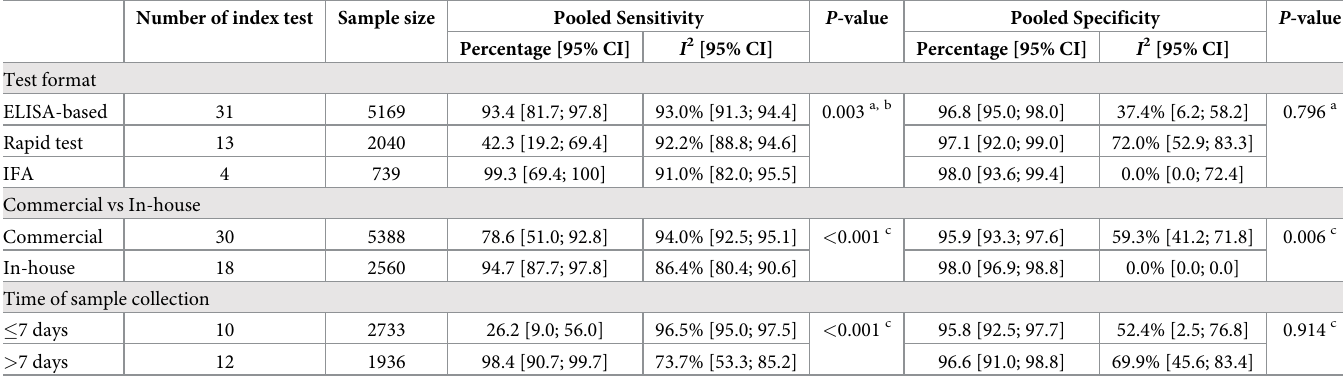
Table 7. Analysis for IgM detection